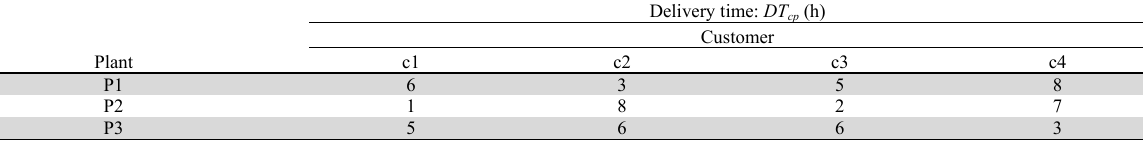
Delivery times for Example 2